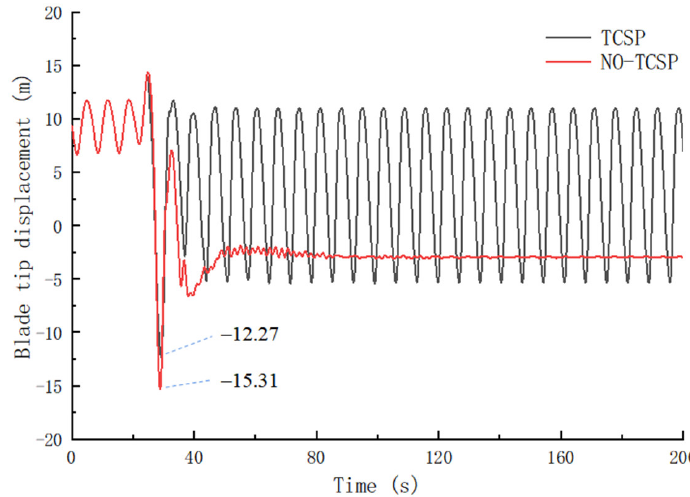
Figure 8. Blade tip displacement comparison.